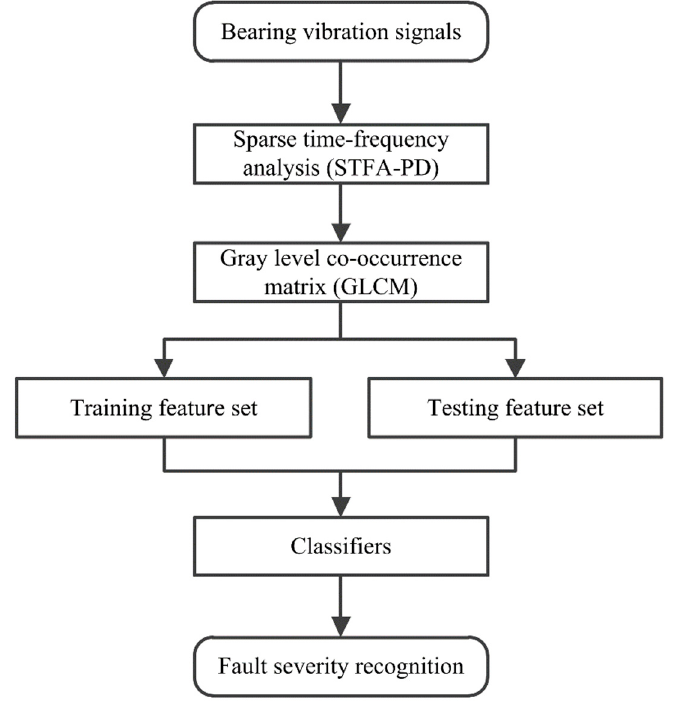
Figure 1. Flowchart of the proposed approach.